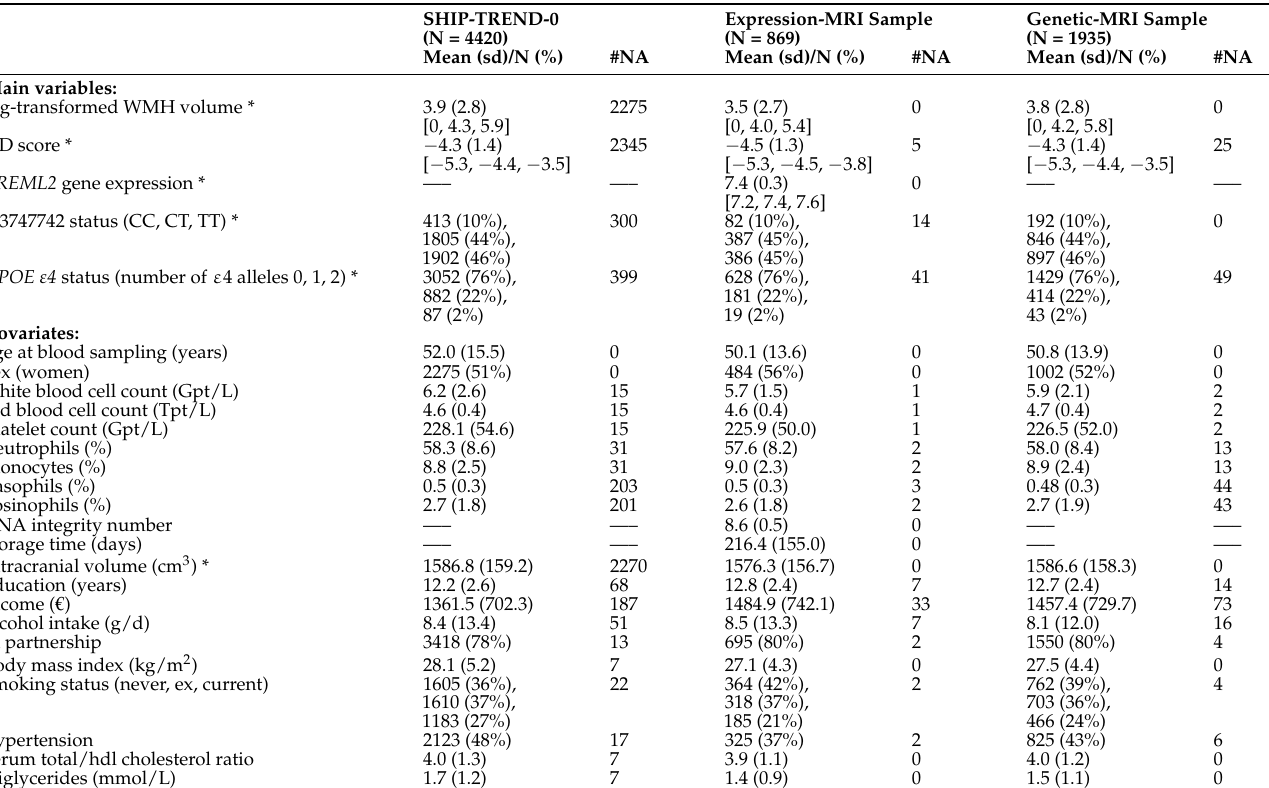
Table 1. Sample description of the study population. The columns expression-MRI sample and genetic-MRI sample refer to the current study. Markedly, restricting the SHIP-TREND-0 sample to the two subsamples did not introduce a selection bias regarding the variables relevant for our study. The variables marked with * were only measured on a subset of SHIP-TREND-0. Numerical variables are listed as mean (standard deviation), categorical variables as number (percentage). For the three main variables we additionally provide the first quartile, median and third quartile in square brackets. #NA is the number of missing values. SHIP-TREND-0 Expression-MRI Sample Genetic-MRI Sample (N = 4420) (N = 869) (N = 1935) Mean (sd)/N (%) #NA Mean (sd)/N (%) #NA Mean (sd)/N (%) #NA